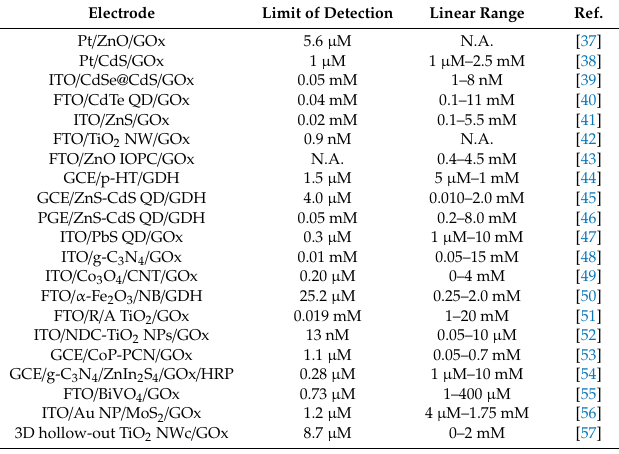
Table 1. Performance of various glucose